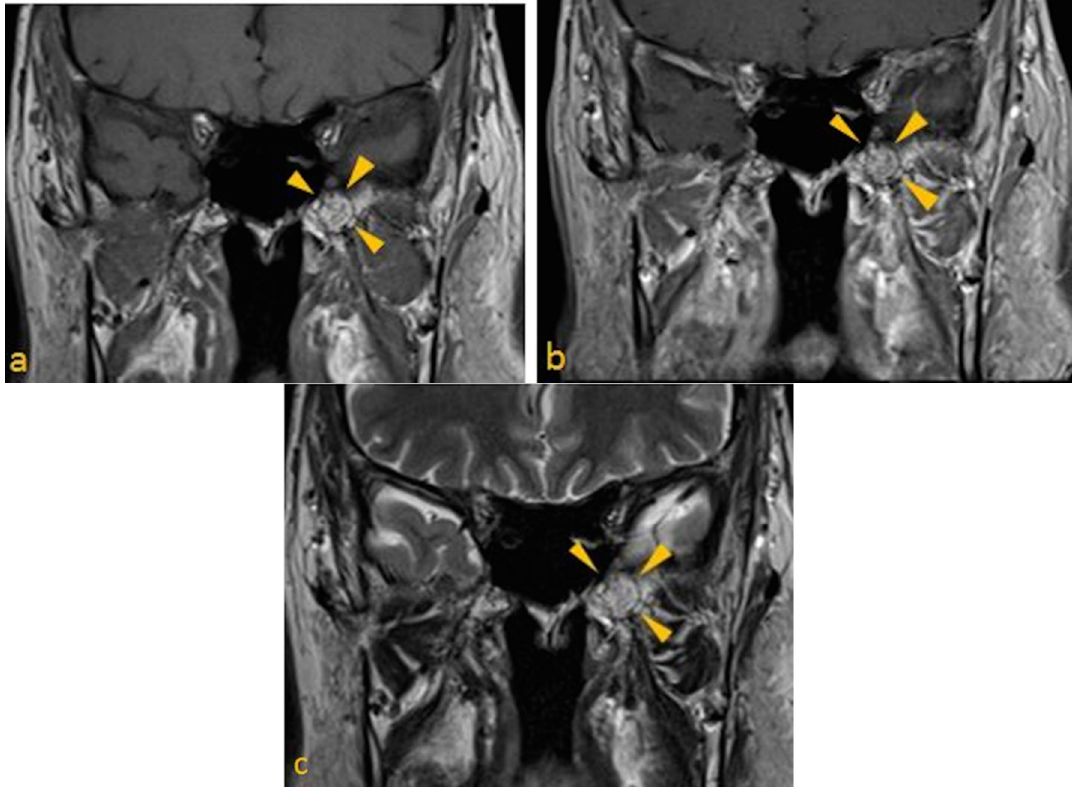
Figure 4. Brain MRI Paracoronal images ( a ) T1 pre-contrast; ( b ) T1 post gadolinium; and ( c ) T2 post gadolinium images, show arrested pneumatization of left sphenoid sinus. Note mild architectural distortion without a focal mass lesion in the marrow of the left